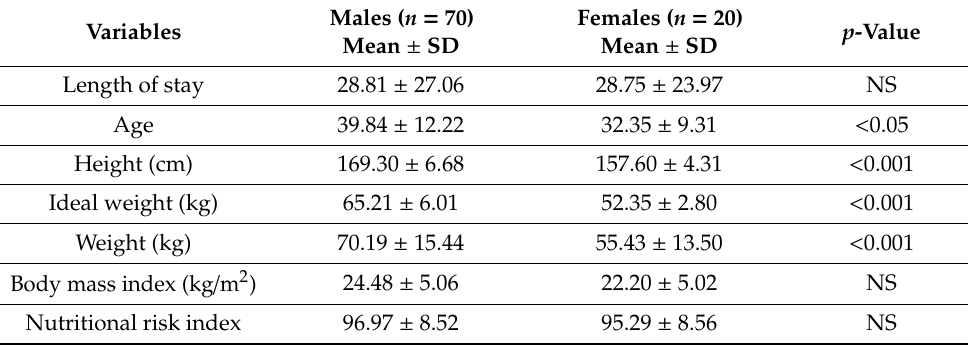
Table 1. Gender di ff erence in baseline general characteristics.